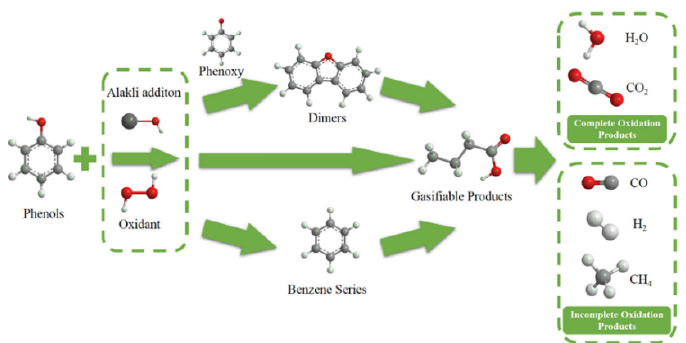
Figure 12. Reaction pathways for catalytic oxidation of phenol in supercritical water. Reproduced from Ref. [86]. Copyright 2020 Elsevier. Table 9. Comparison of the effectiveness of phenol removal through the supercritical water gasification process. Catalyst Oxidant